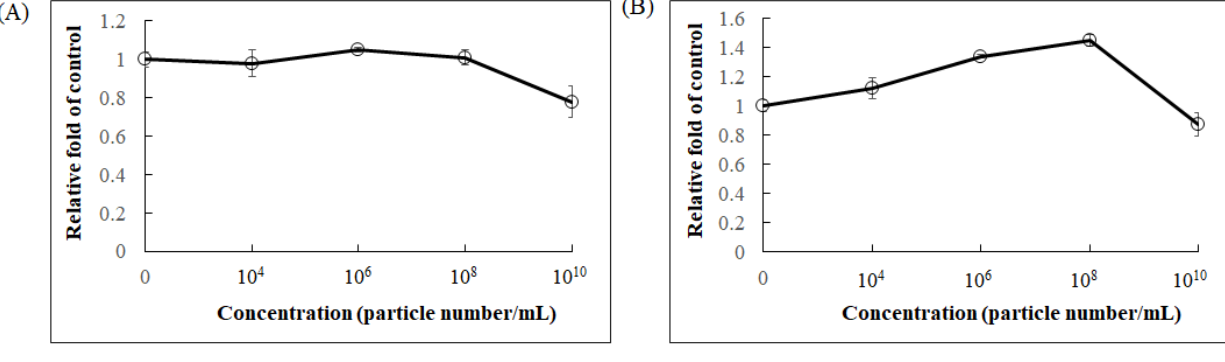
Figure 6. The effect of F. nucleatum -derived EVs on cell proliferation and cell viability. ( A ) Cell survival by crystal violet stain and ( B ) mitochondrial activity by MTT measurement in Caco-2 cells after 36 h treatment. Data are shown as means ± SD ( n = 3).